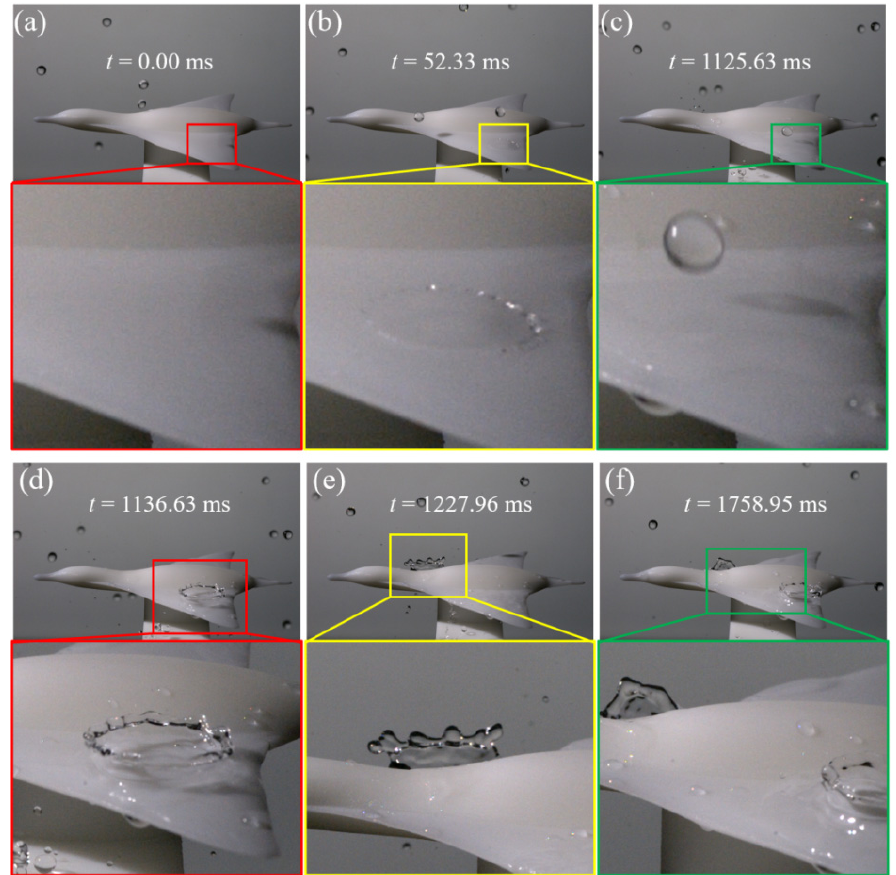
Figure 3. A liquid film develops on the surface of the hydrophilic model as droplets fail to escape from the hydrophilic surface after impact; the crown phenomenon appears as the liquid film continues to accumulate (see more details in “Supporting Movie S1” in the Supplementary